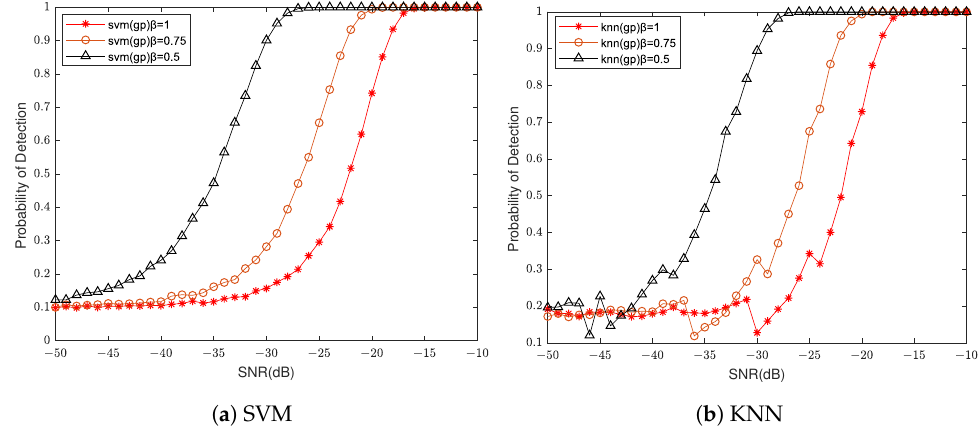
Figure 1. Based on different machine learning pairs β value selection.